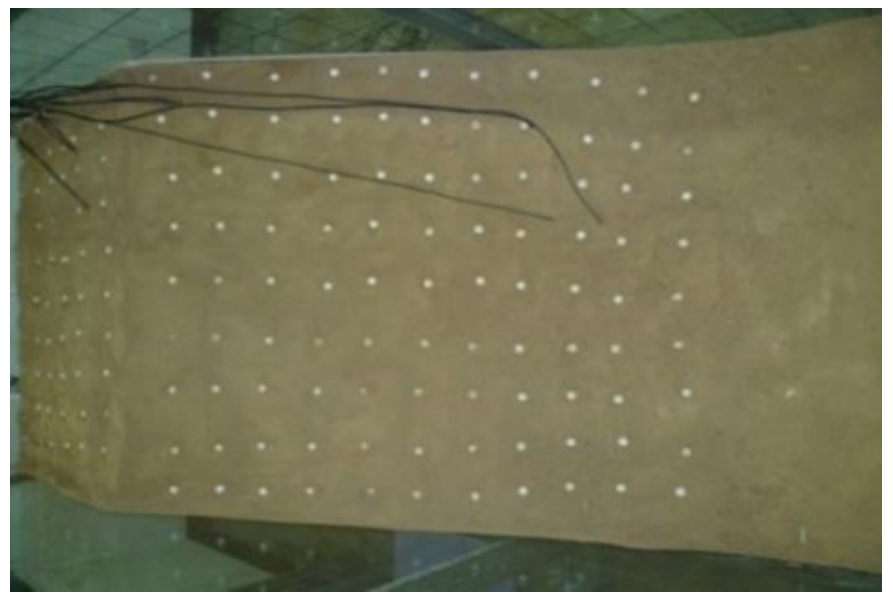
Figure 1. Model slope fabrication.